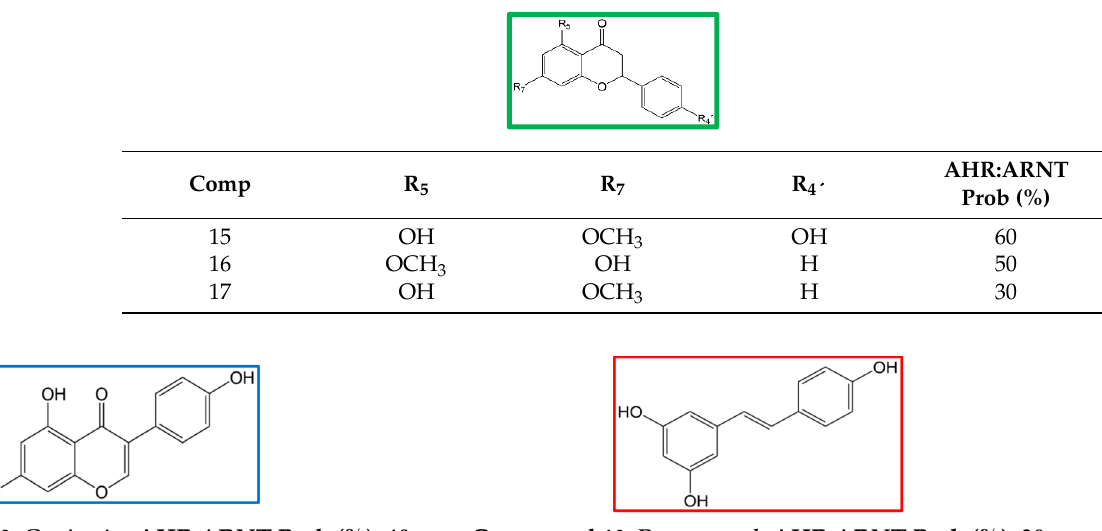
Table 2. Structure of active flavonones to block the formation of the functional heterodimer AHR: ARNT. Percentages of probability of the activity estimated by molecular docking.